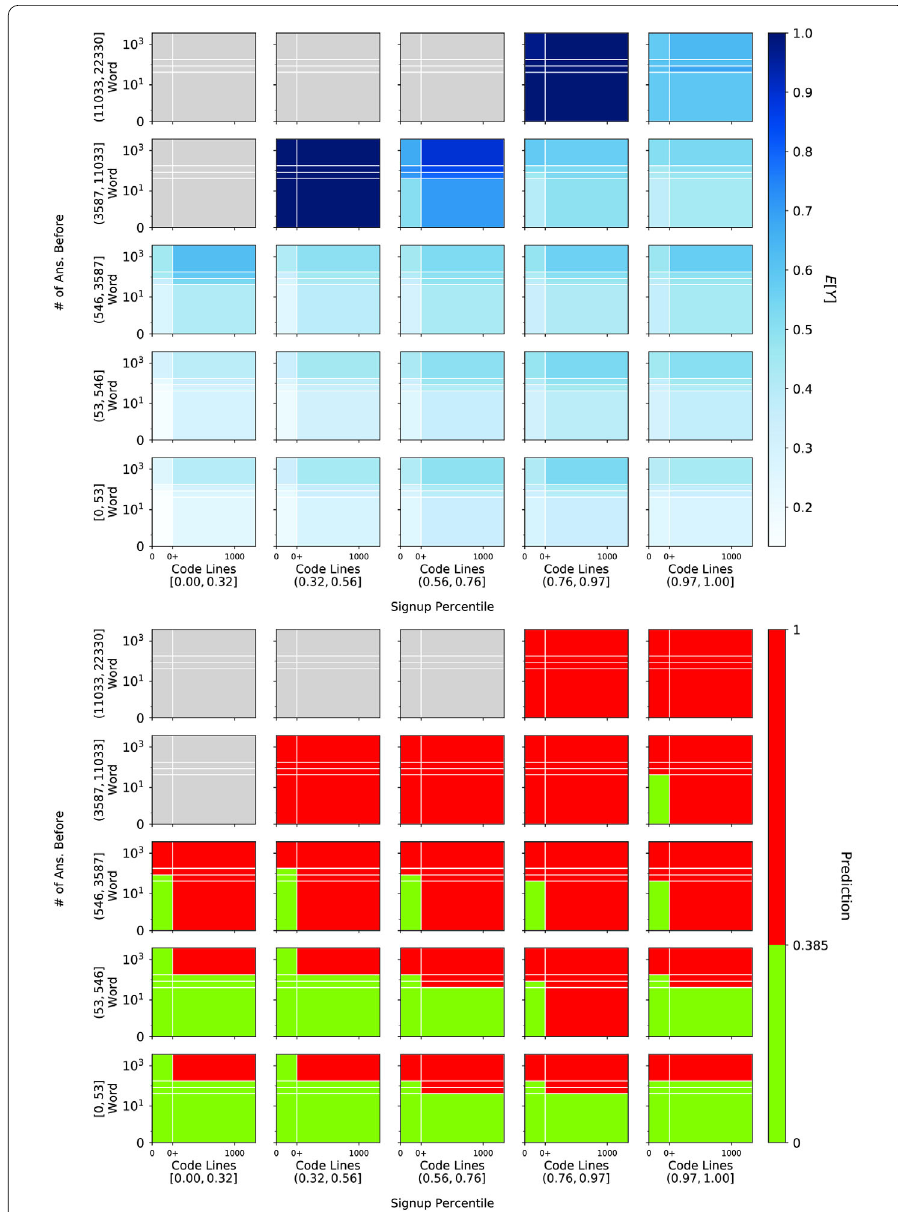
Figure 9 Visualization of the S3D model learned for Stack Exchange, showing the decomposition of feature space defined by the four most important features. These plots represent the partition of the 4-dimensional hypercube, and show how the acceptance probability (top) and corresponding predicted acceptance (bottom; red for label 1 and green for 0) of data points vary within the space. Gray areas have no